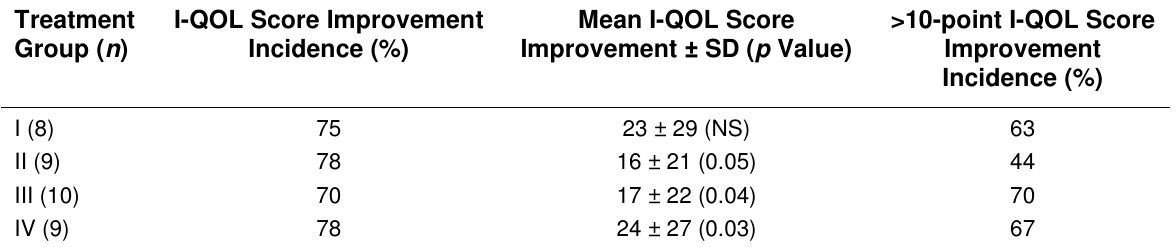
Improvement at 12 Months in I-QOL Overall Score vs.